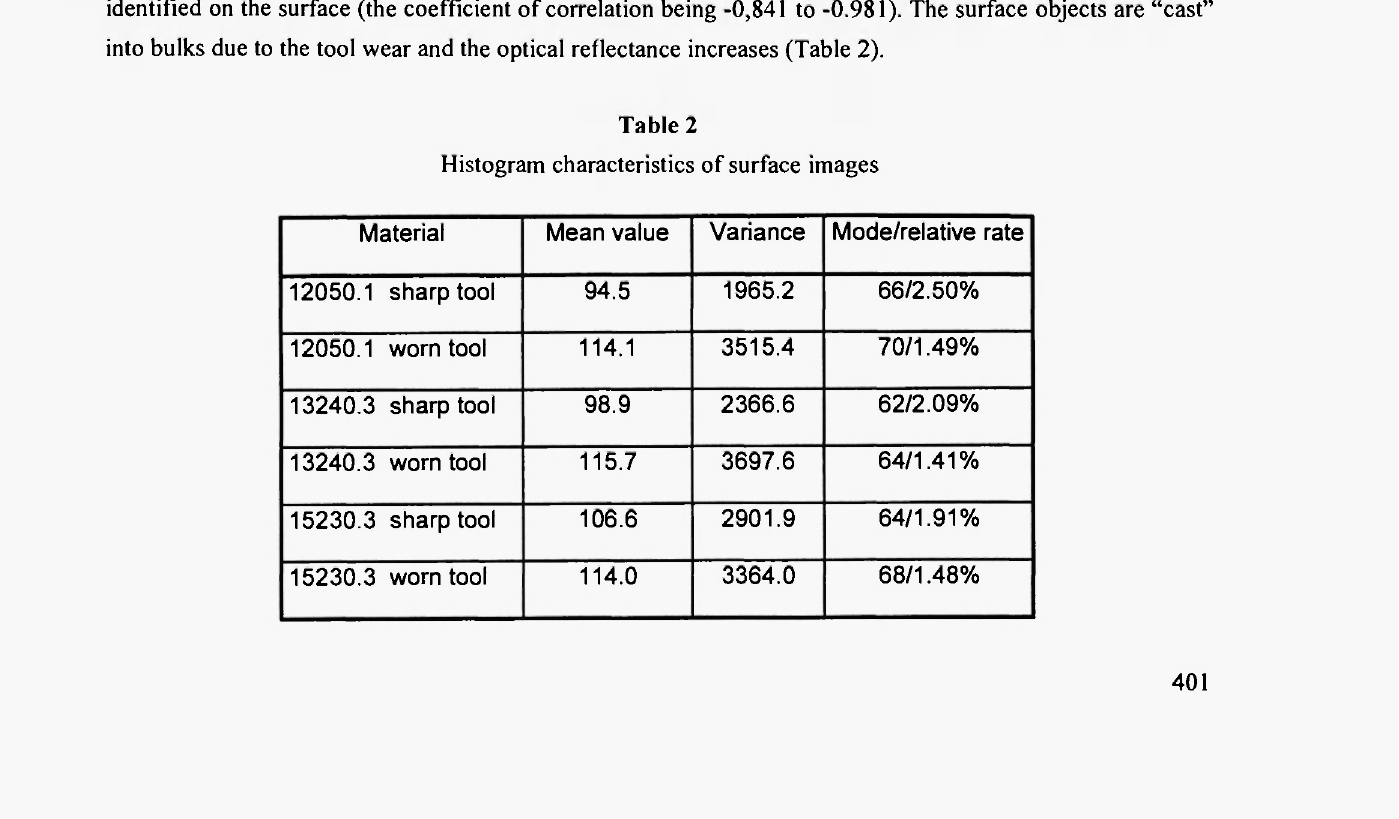
Histogram characteristics of surface